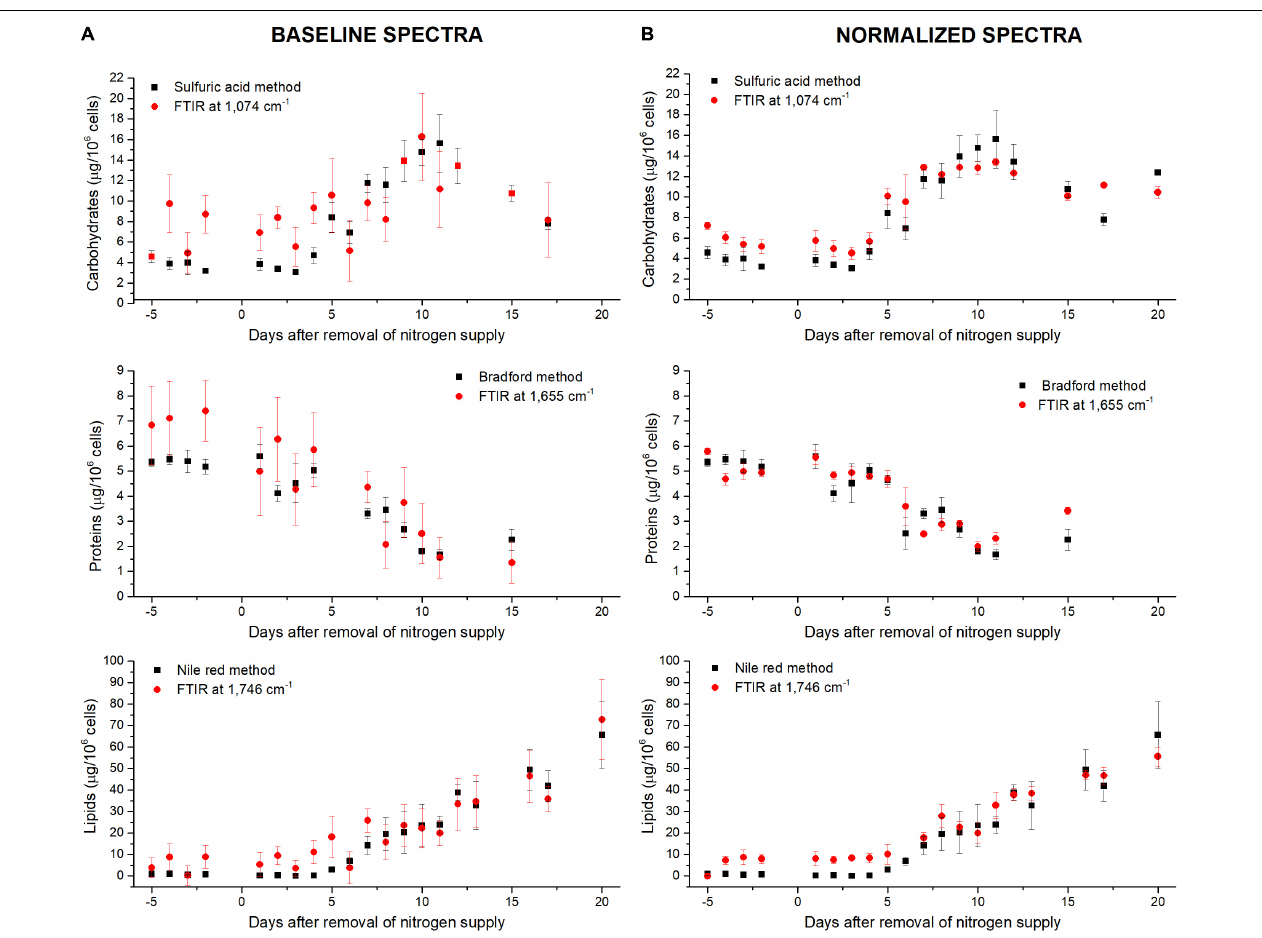
FIGURE 4 | Comparison between standard biochemical and FTIR quantifications along the N-starvation performed in a photobioreactor (Scarsini, 2021) considering (A) baseline-corrected spectra or (B) baseline and normalized-corrected spectra. FTIR quantifications are performed at 1,074 cm – 1 for carbohydrates, 1,655 cm – 1 for proteins and 1,746 cm – 1 for